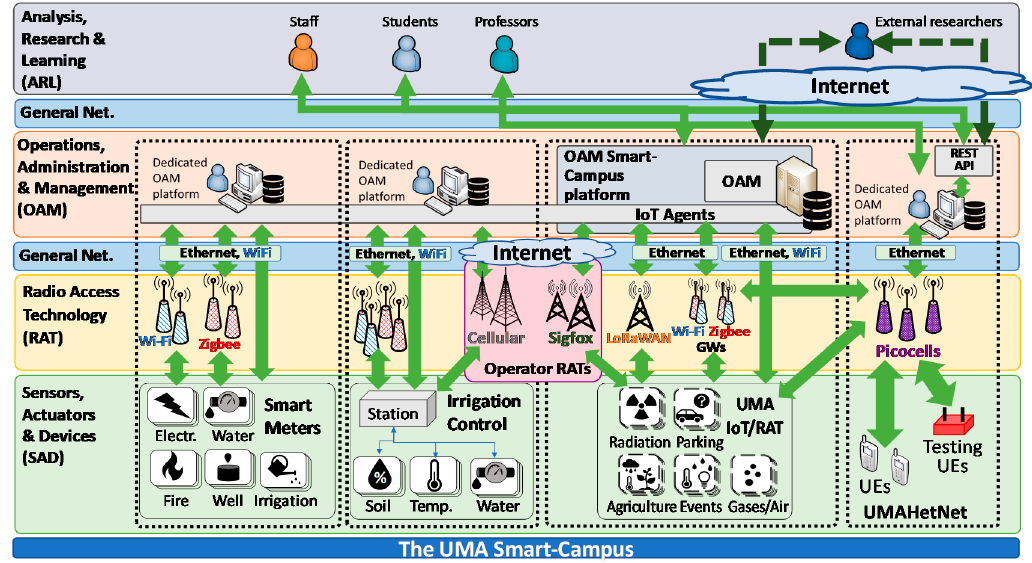
Figure 5. UMA Smart-Campus framework and general scheme of the different information and communication technologies (ICT) infrastructures.